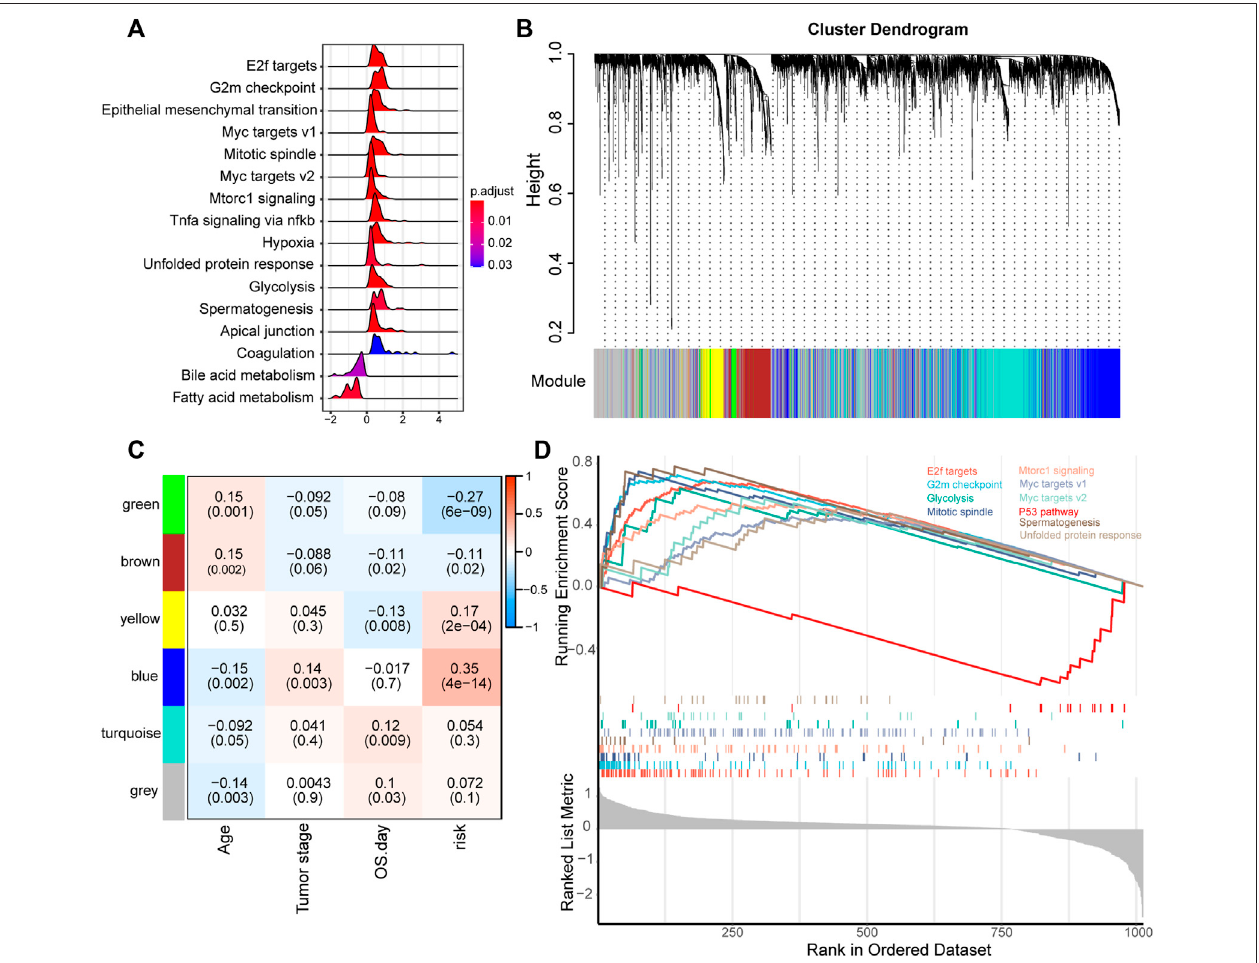
FIGURE 5 | Functional analysis of genes correlated with the ECM organization-related prognostic signature. (A) GSEA of the hallmark gene set for risk groups based on pre-ranked fold change between high-risk and low-risk groups calculated by DESeq2. (B) Clustering dendrogram of the top 5,000 variant genes with dissimilarity based on the topological overlap together with assigned module colors. (C) Module-trait relationships. Each row represents a module eigengene, each column corresponds to a clinical trait, and each cell contains the corresponding correlation (upper number) and p value (lower number). (D) GSEA of the hallmark gene set of genes in the blue